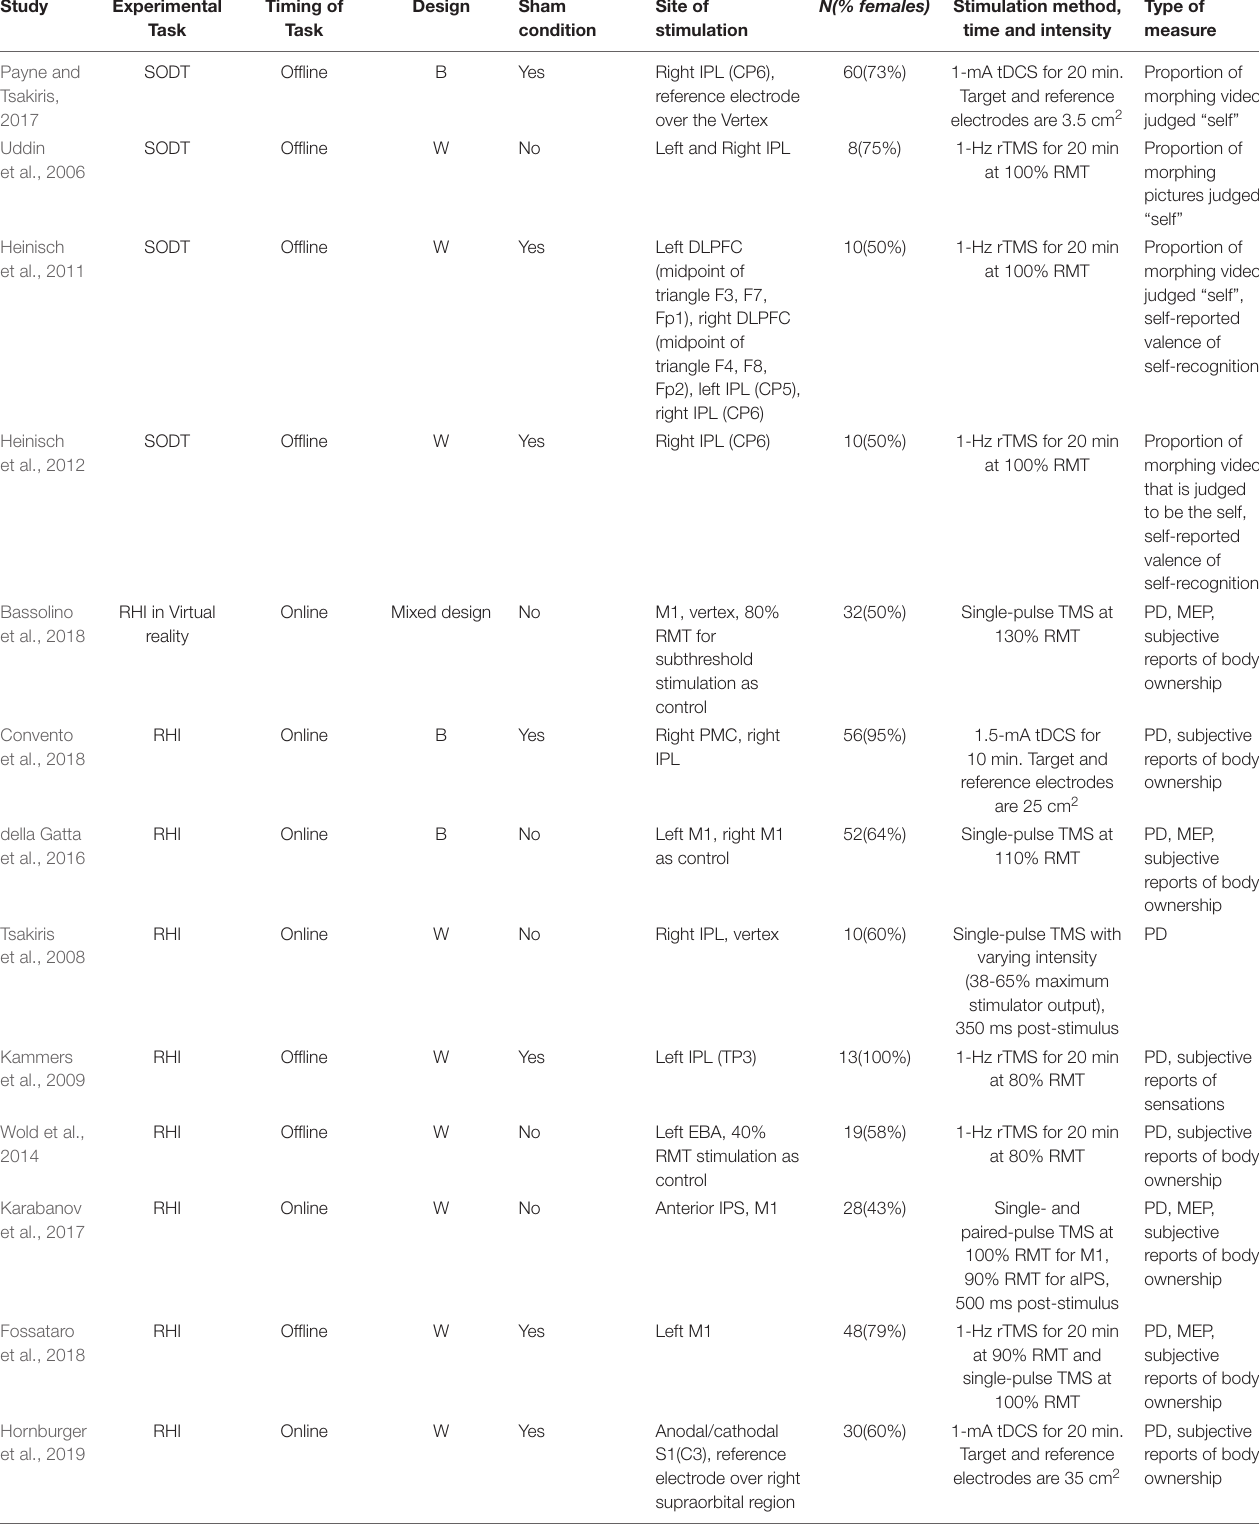
TABLE 2 | Summary of experimental paradigms of NV-SRP